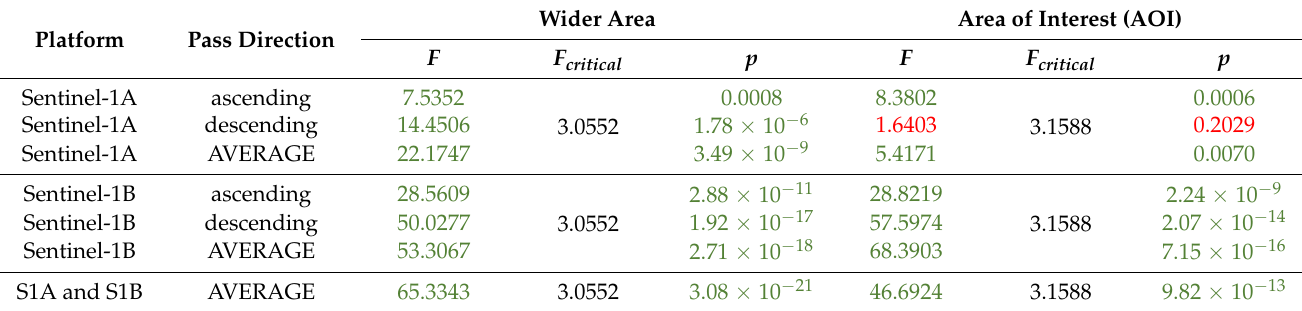
Table 3. ANOVA test results for coherence values from Sentinel-1A, Sentinel-1B in ascending and descending pass direction, average Sentinel-1A, average Sentinel-1B, and overall Sentinel-1A and Sentinel-1B average. The successful tests are in green, whereas those that failed are in